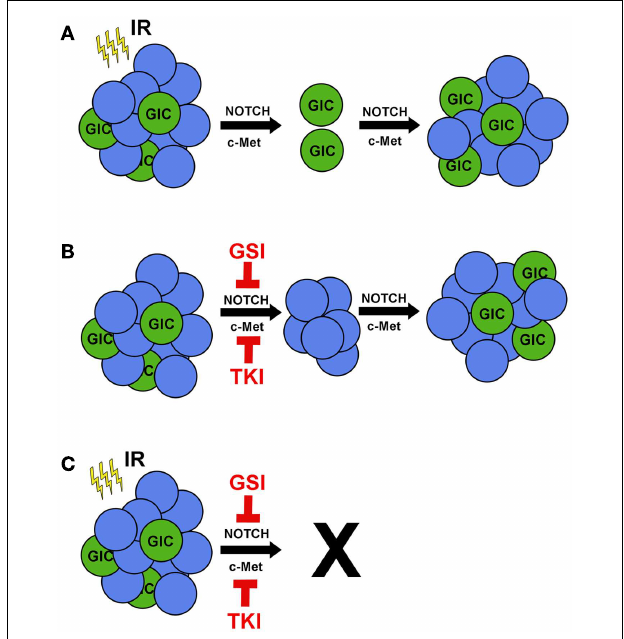
FIGURE 1 | Ionizing radiation in combination with c-MET or NOTCH inhibitors prevents tumor recurrence. (A) Treating GBM with IR reduces tumor volume, but radioresistant GICs remain. IR promotes activation of the pro-survival pathways NOTCH and c-MET in GICs, leading to tumor recurrence. (B) Single treatment of GBM tumors with either gamma secretase inhibitors (GSIs) to target NOTCH or tyrosine kinase inhibitors (TKIs) to target c-MET would kill GICs specifically and have a minor effect on tumor volume. (C) Combinatorial treatment of GSIs orTKIs with IR would target both GICs and non-GICs and prevent tumor